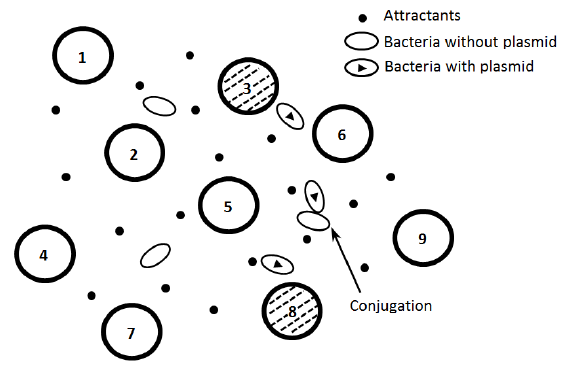
Figure 4: Static topology with a single attractants uniformly distributed at random